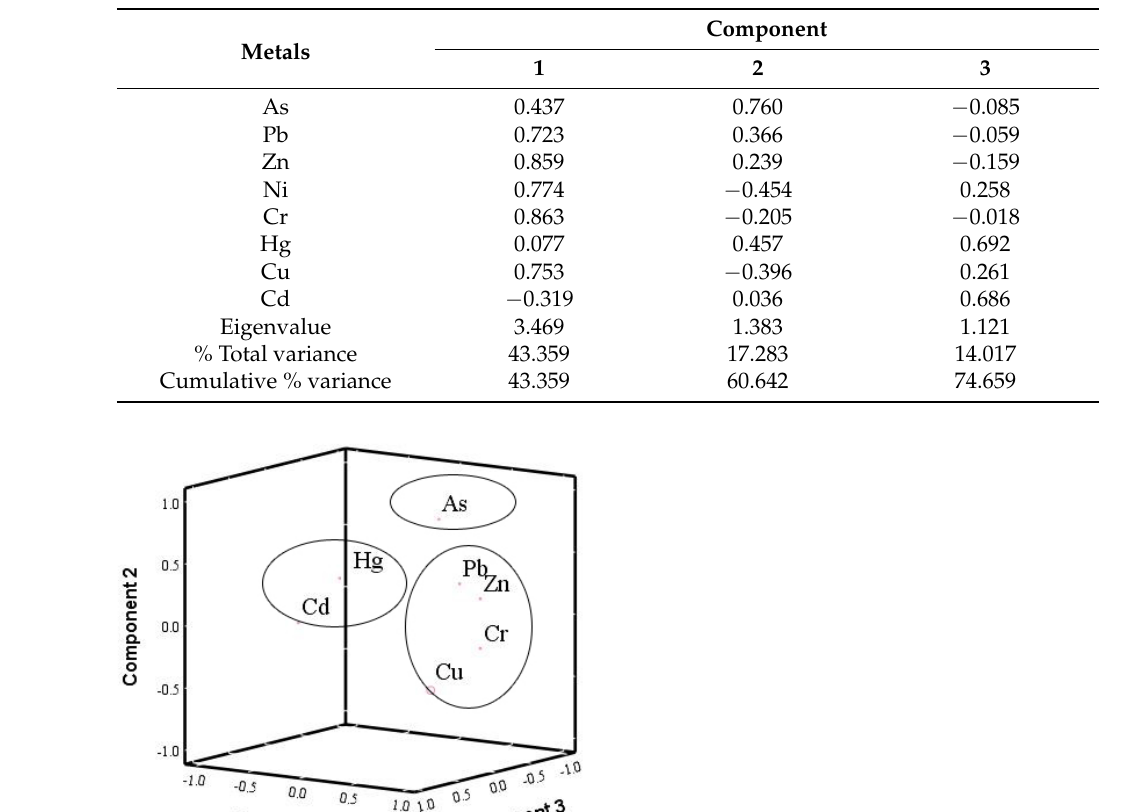
Table 7. Rotation component matrix of factor analysis.